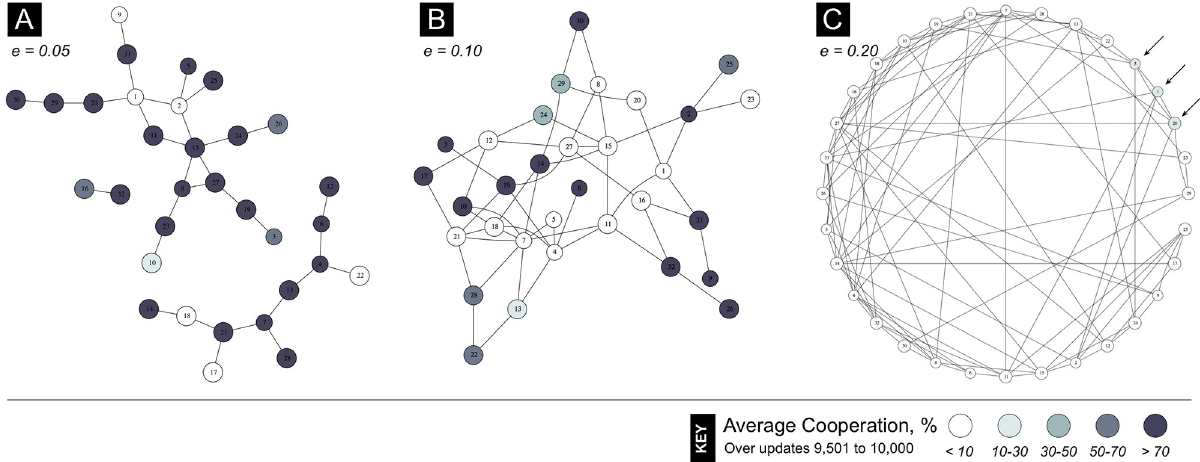
Fig 4. Collaboration fosters cooperation on sparse networks. Percent of time that individuals in the population played Cooperate across updates 9,501 to 10,000, with colouring as per the key at bottom of figure. Presentation is for a single run over each of three example networks with differing edge density e , as given in panels A – C , at benchmark conditions ( b = 3, c = 4) and collaboration parameter p = 0.5. Note that in panel A ( e = 0.05) the network is disconnected, being comprised of three components; and in panel C , only three agents (indicated by arrows) cooperated significantly (10 − 30%) over the sample